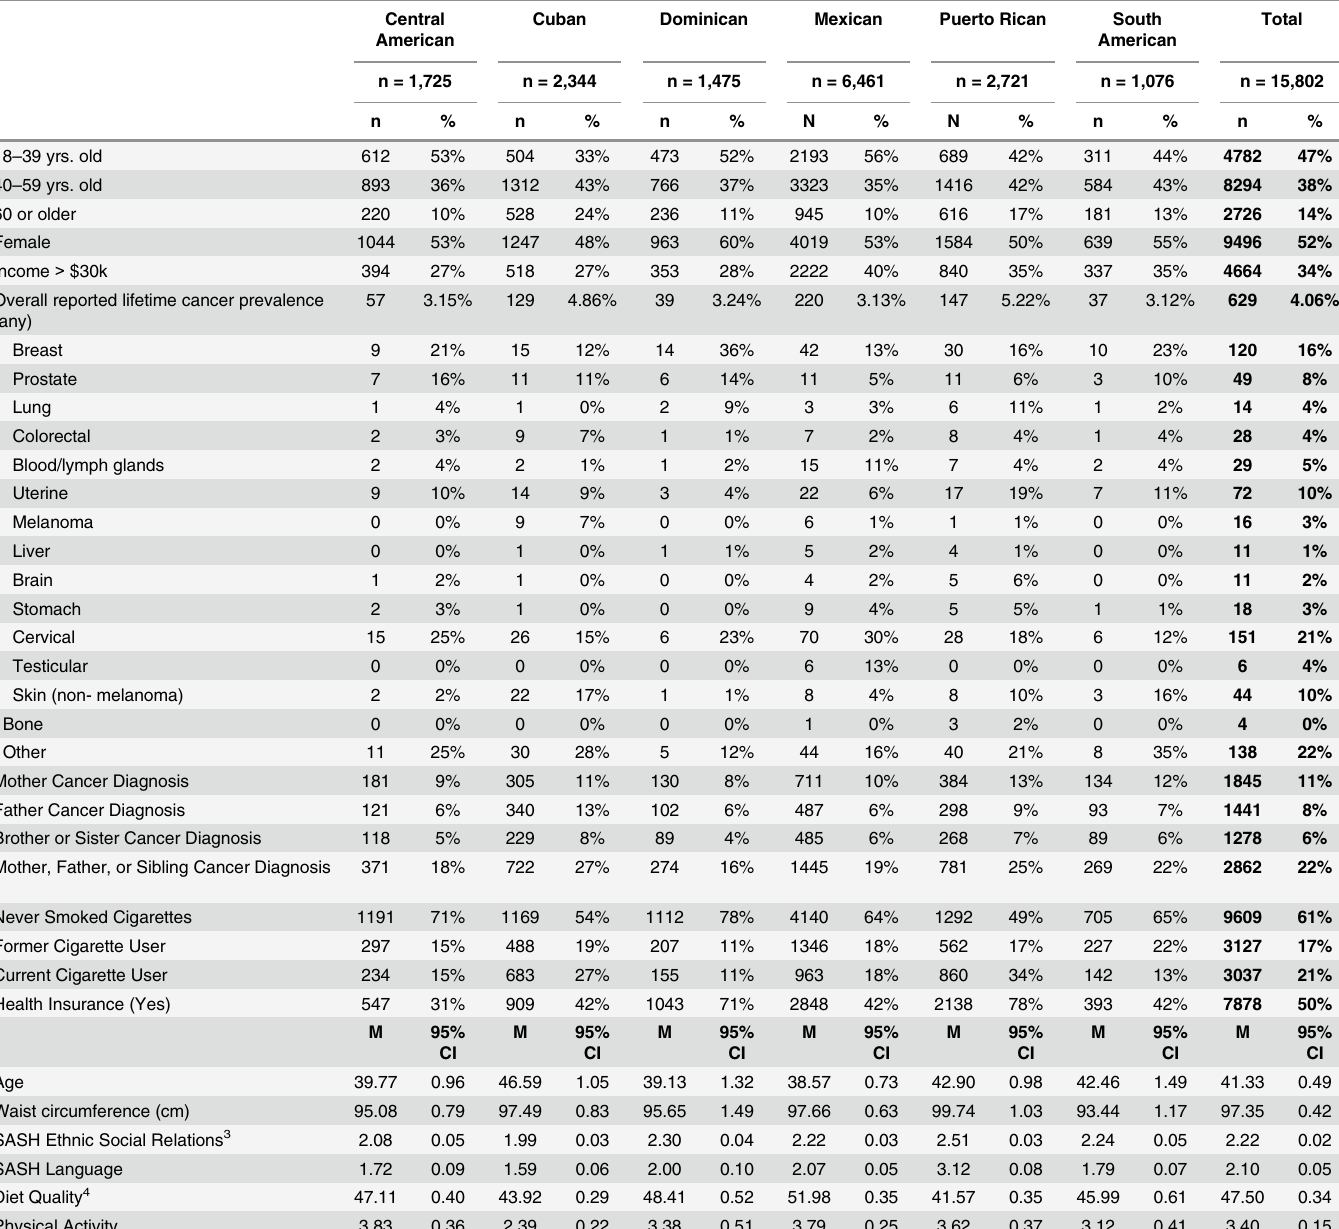
Table 1. Descriptive statistics for study variables and cancer prevalence 1